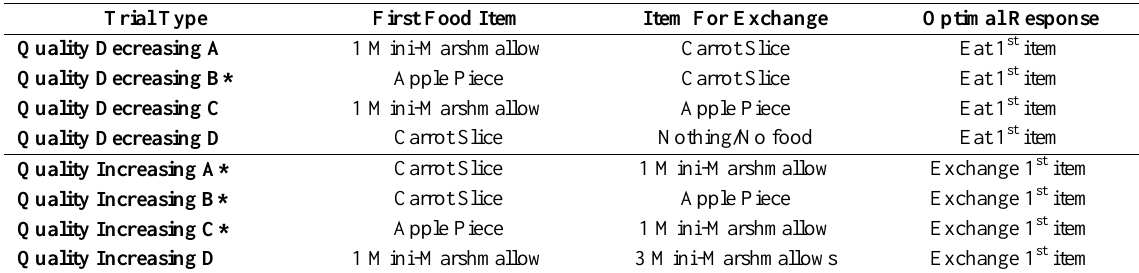
Food Exchange Trial Type Descriptions for Exchange Training in Experiment